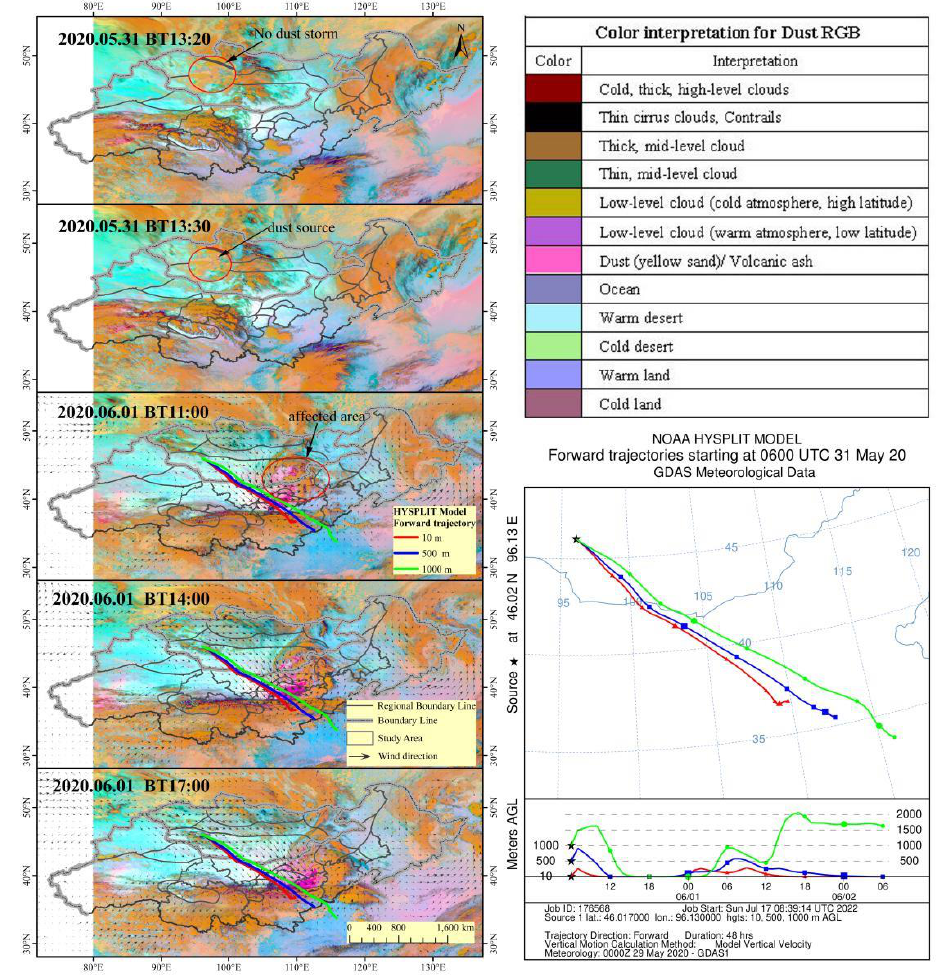
Figure 2. Map of dust storm moving path on 1 June 2020. On the left, black arrow is the wind direction; pink shading is recorded as dust storms, cyan is the warm desert, and ginger yellow is thick mid-level clouds. On the lower right corner is the forward trajectory of dust storms simulated by HYSPLIT model (Red, green and blue colors represent airflow at 0, 500 and 1000 m respectively).